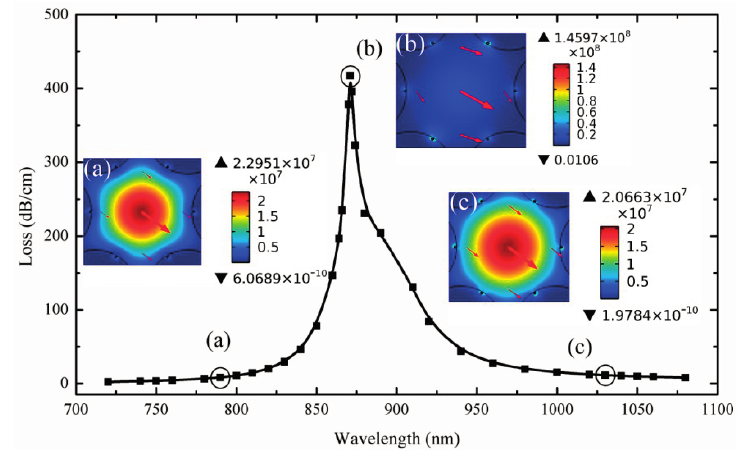
Figure 2. Calculated loss spectra of the core modes with the refractive index of the liquid at 1.4. Insets show the electric field (E field) distributions of the core modes, and the arrows indicate the polarized direction of electric